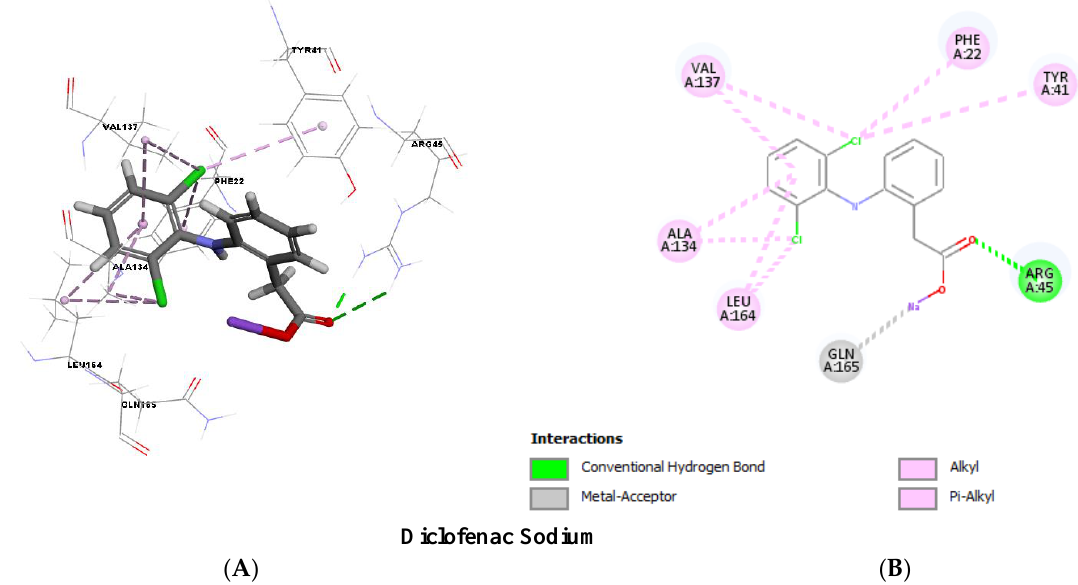
Figure 11. Molecular docking analysis showing (Three-dimensional) 3D ( A ) and (two-dimensional) 2D ( B ) representation of interaction patterns of DC with CrtM receptor.